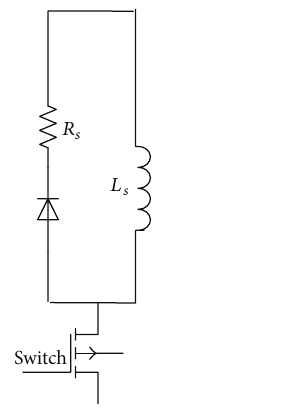
Figure 21: The overall structure of RLD snubber.